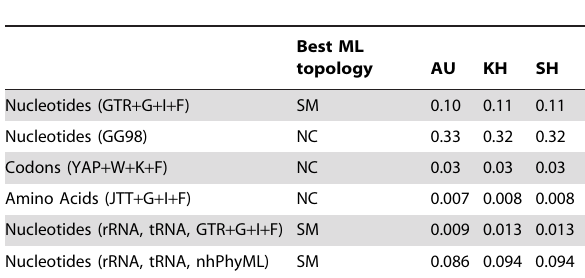
Table 3. Comparison of the two competing topologies (scleractinian monophyly, SM, and ‘‘naked coral’’, NC) using the Approximately Unbiased (AU), Kishino-Hasegawa (KH) and Shimodaira-Hasegawa (SH) tests for a variety of tree reconstruction